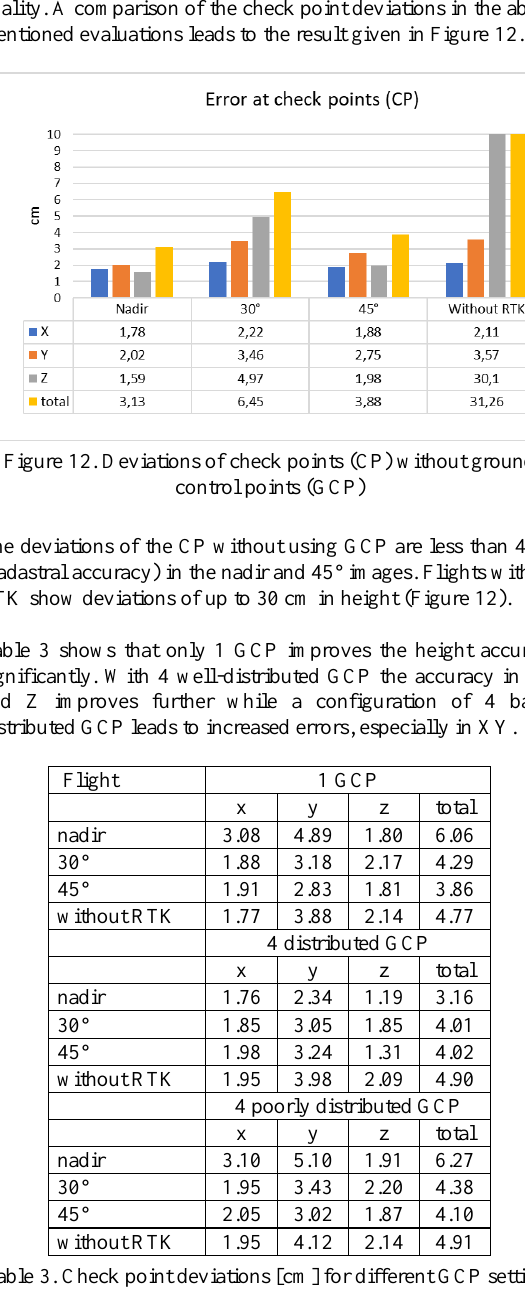
(Figure 10, white: GCP, red: CP). Independently of GCP settings, the mean reprojection error lies in the order 0.5 px. A final investigation of these effects and for possible reasons will be carried out in the near future.